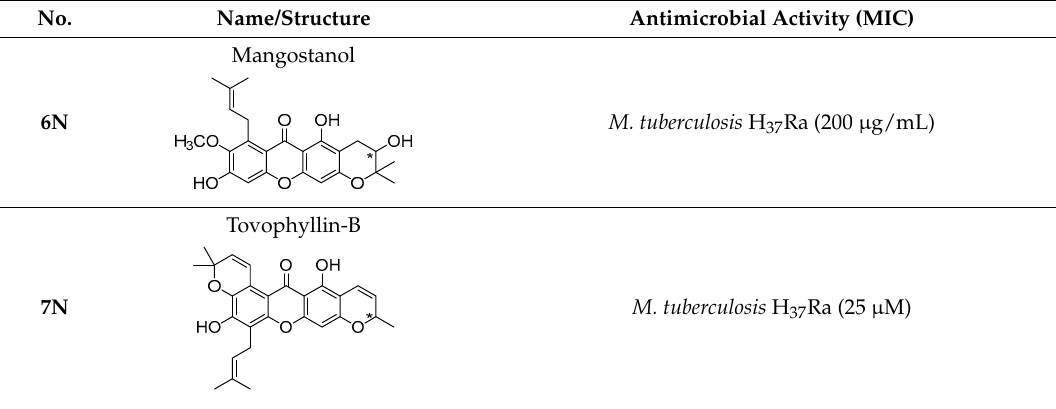
Table 2. Antimicrobial activity of natural CDXs with pyran groups.